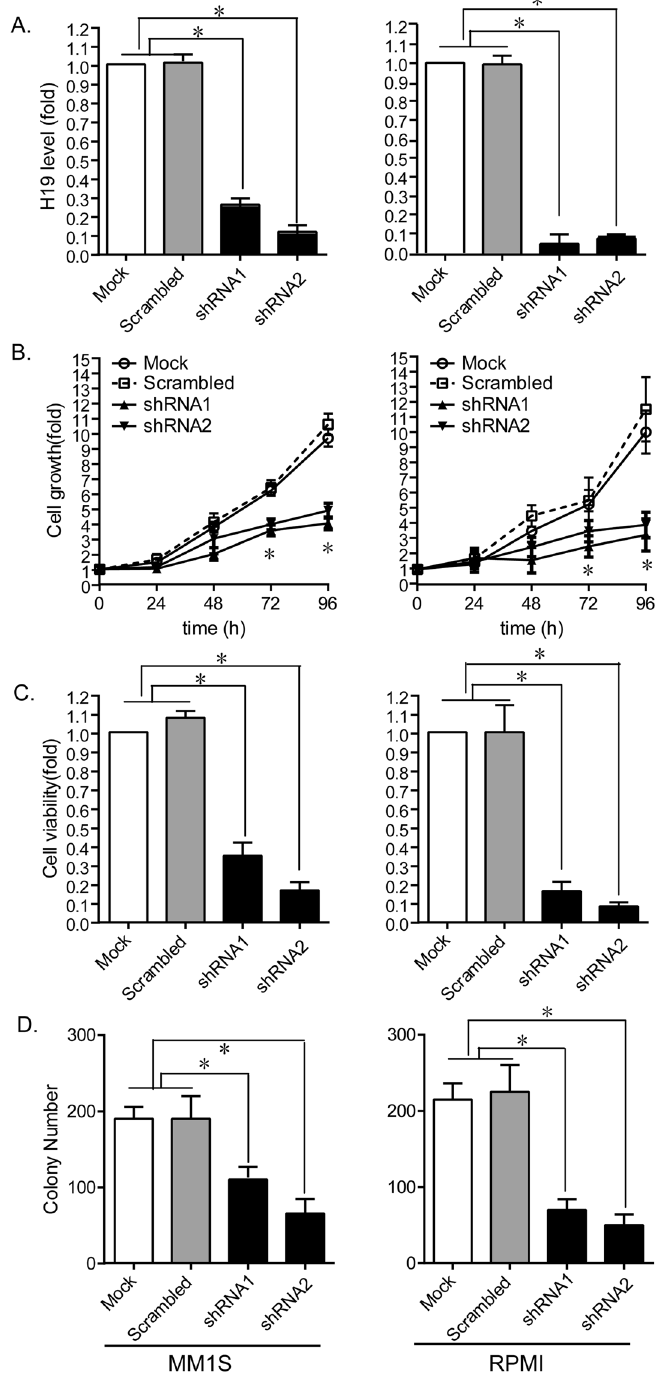
Figure 2. Effects of H19 on growth of MM cells. ( A ) Expression of H19 was significantly silenced by transfecting MM1S or RPMI cells with shRNA. Loss of H19 expression significantly inhibited cell ( B ) proliferation, ( C ) viability, and ( D ) colony formation. ( * P < 0.01, Figure is representative of 3 experiments with similar